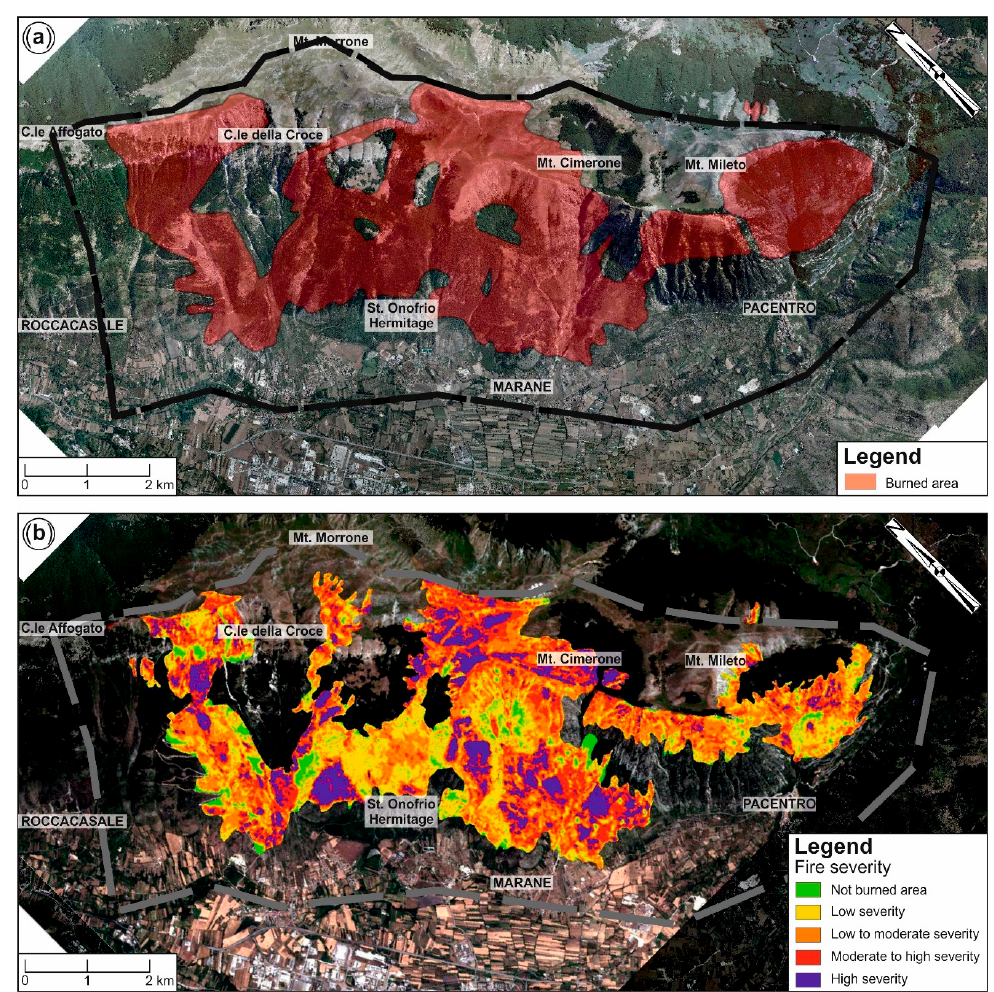
Figure 4. ( a ) August 2017 fire perimeter map; ( b ) fire severity map (modified from Frate et al. [47]). The dashed box indicates the location of the study area.